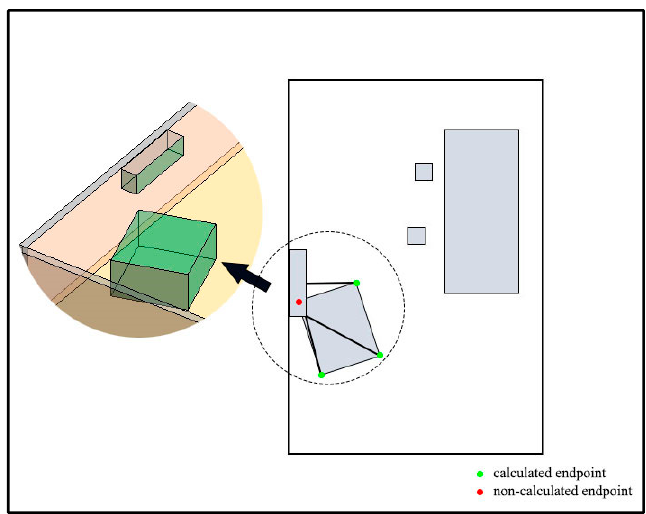
Figure 7. The generation of narrow gaps. ( a ) The projection of Room A. ( b ) The buffer of the 𝐼𝑂 A. ( c ) The minimum distances (MDs) between the endpoints of A and B, C, and D. ( d ) The narrow gaps of 𝐼𝑂 A. ( e) All MDs between the endpoints of each 𝐼𝑂 and the 𝐼𝑂s in its buffer. ( f ) The narrow gaps of Room A.